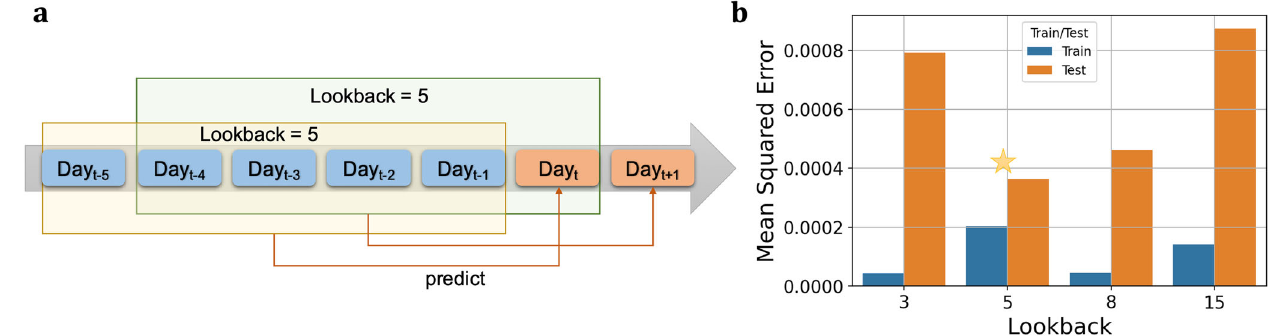
Fig. 5 Schematic work fl ow and evaluation for LSTM neural network. The schematic work fl ow and parameter tuning for the LSTM neural network: a Schematic work fl ow used by the LSTM model with the time-series immersion dataset; b Taking Cast Stellite 6 as an example, the mean squared errors of the different lookbacks for the LSTM model on the training and testing set are shown. LSTM long short-term memory.